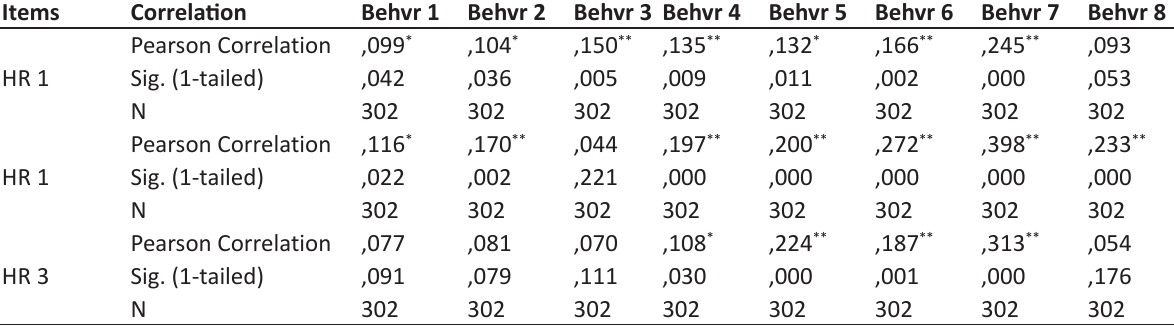
Table 6. Correlations between the CT behavior and the PE-ST Health repercussions